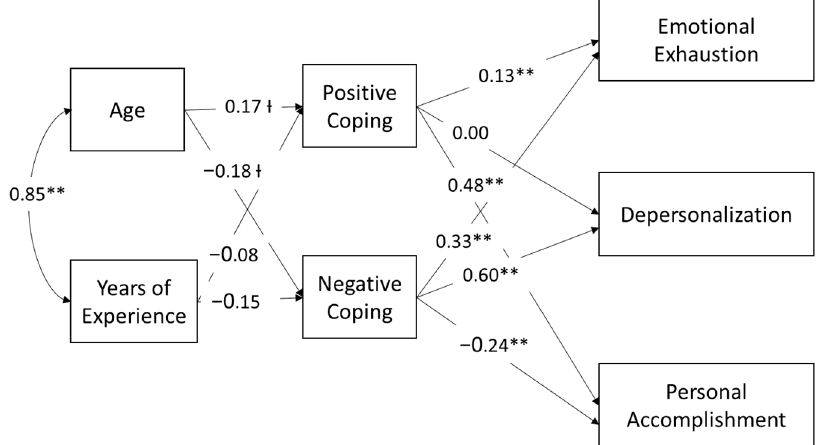
Figure 3. Path analysis of the relationship between age, job experience, and burnout as mediated by positive and negative coping. Ɨ p < 0.10, , ** p < 0.01. Table 4. Parameter estimates for mediation model with age and job experience as the exogenous variables, coping as mediating variables, and burnout as the outcome variable: Direct and indirect effects. 95%